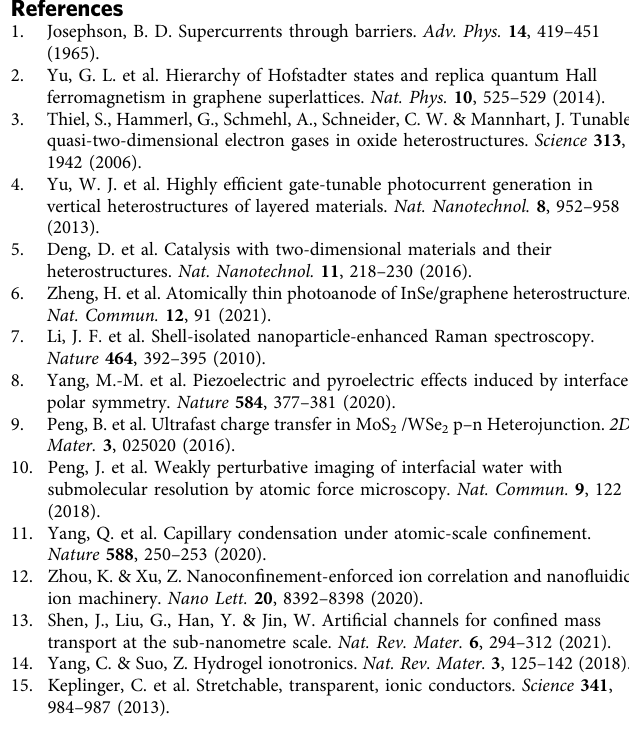
R 1 (cid:1) V ¼ IR s = Wdx ¼ R s cV 0 Lu , where R s is the sheet resistance of silicon. Before the 0 charge packet gets equilibrium, however, the potential drop across the silicon expo- nentially increases when the light beam starts to move, i.e., V ¼ (cid:1) V ð 1 (cid:2) e (cid:2) kt Þ ¼ R s cV 0 L ð 1 (cid:2) e (cid:2) ks u Þ u : Data availability